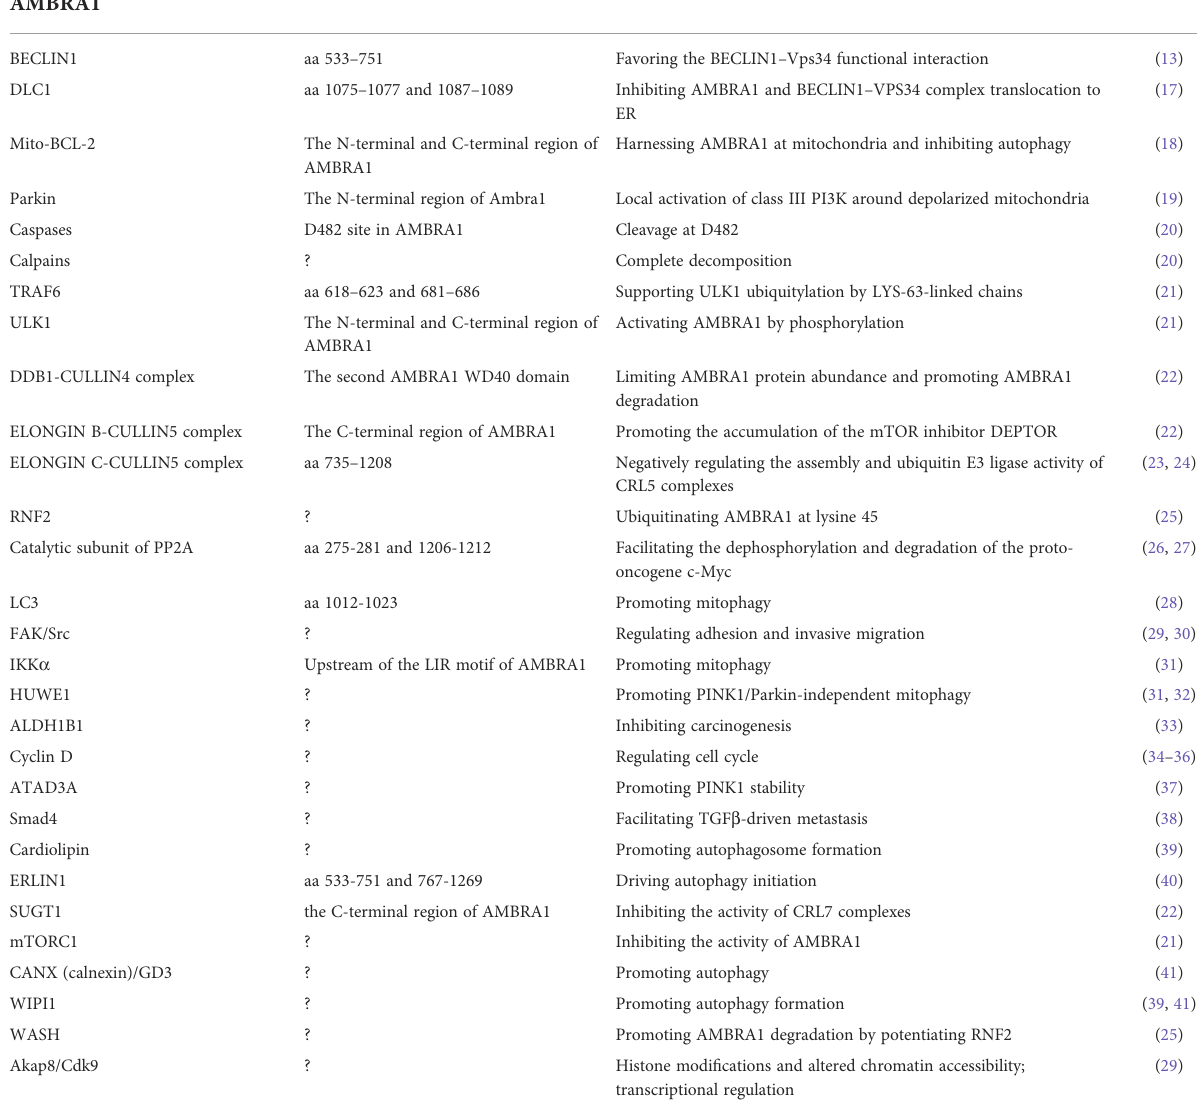
TABLE 1 The interaction partners of AMBRA1